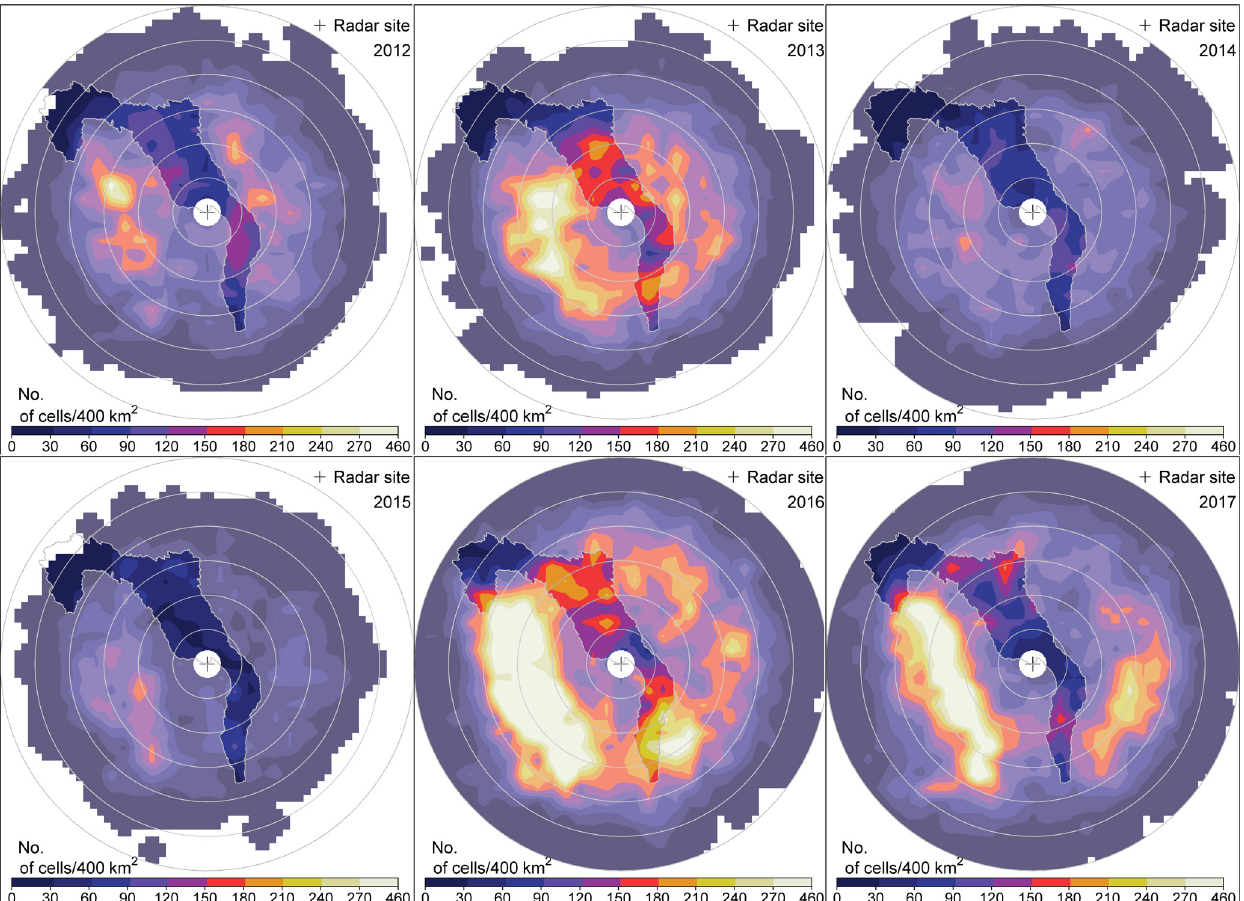
Figure 7. Same as Fig. 6 but for the period 2012–2017.